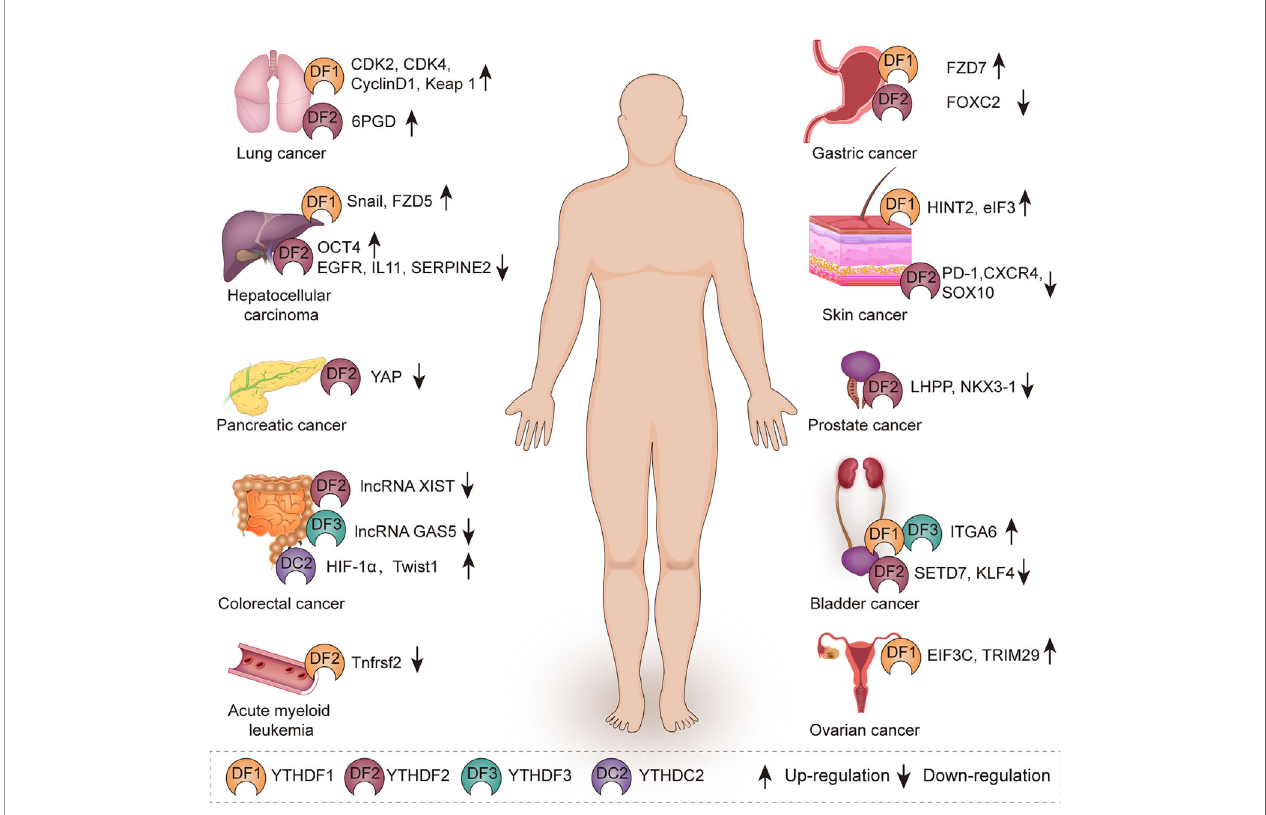
FIGURE 2 | The role of YTH family proteins in human cancers. YTH family proteins are associated with various kinds of cancers including lung cancer, hepatocellular carcinoma, pancreatic cancer, colorectal cancer, acute myeloid leukemia, gastric cancer, skin cancer, prostate cancer, bladder cancer, and ovarian